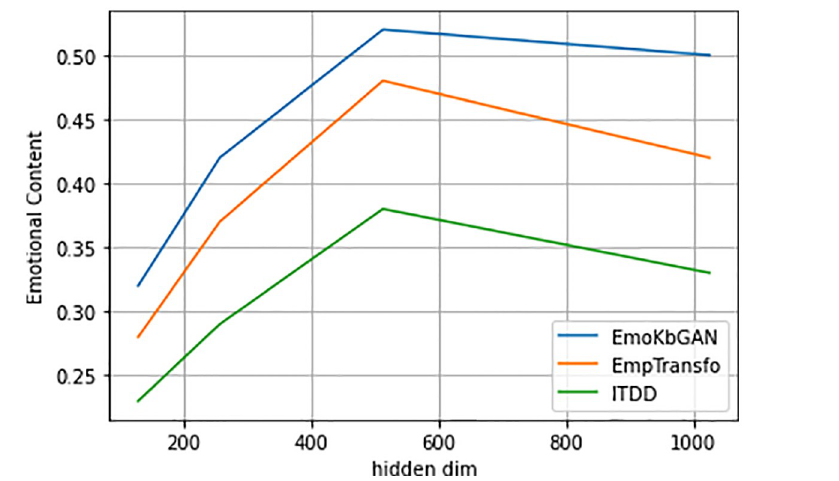
Fig 5. Emotional content vs hidden